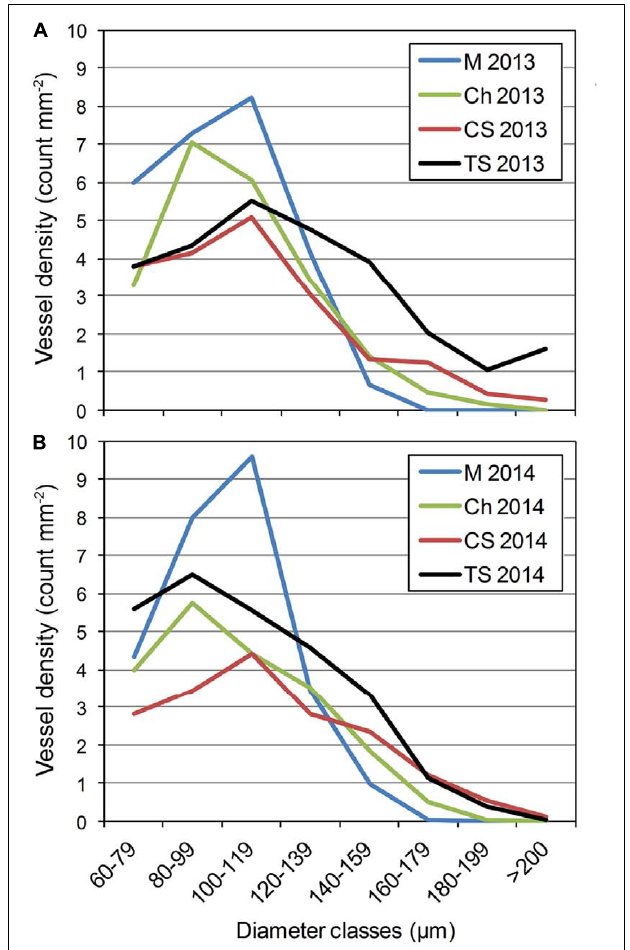
FIGURE 2 | Distribution of xylem vessel diameter observed in the stem of V. vinifera L. cvs Merlot (M), Chardonnay (Ch), Cabernet Sauvignon (CS), and Thompson Seedless (TS) in (A) 2013 and (B) 2014. Please see Supplementary Tables 4, 5 for further statistical analysis of